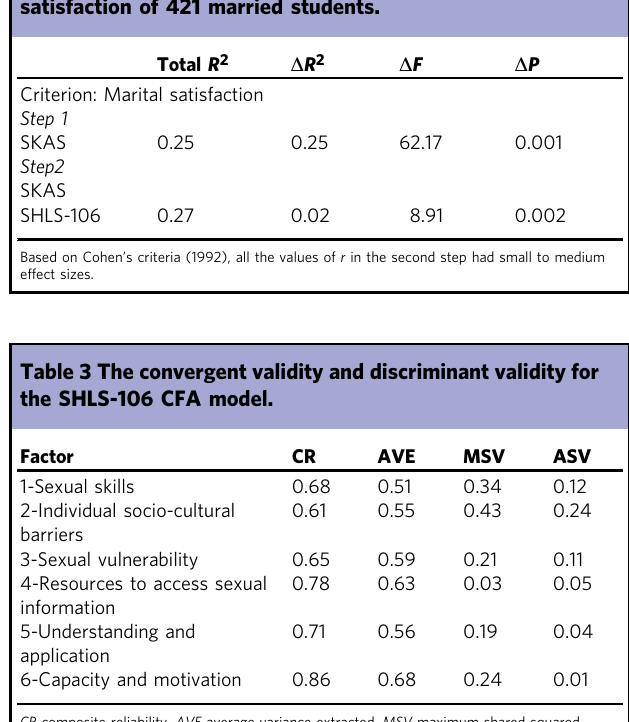
HUMANITIES AND SOCIAL SCIENCES COMMUNICATIONS |